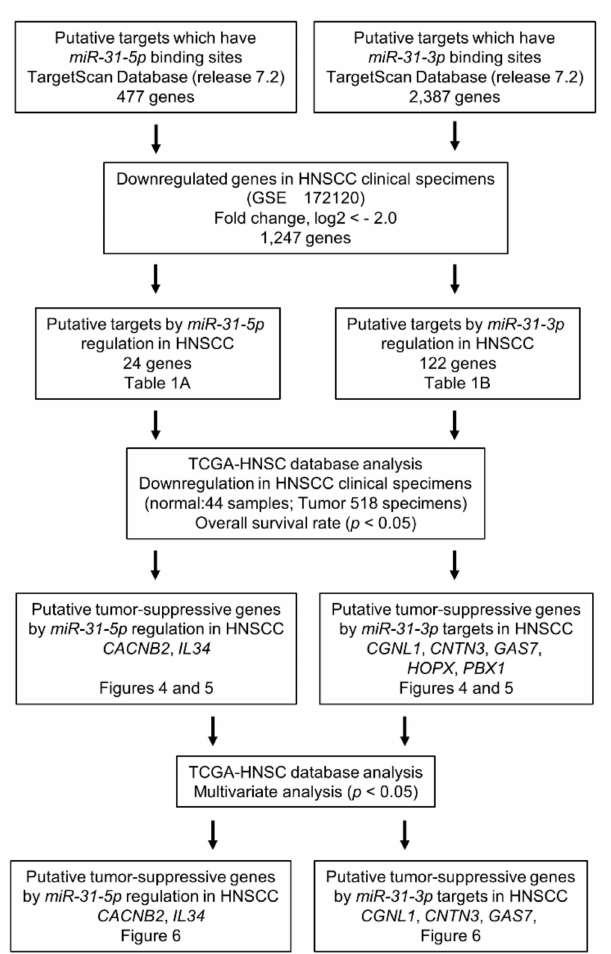
Figure 3. Flow chart of the strategy used to identify putative tumor suppressor genes regulated by miR-31-5p and miR-31-3p in HNSCC